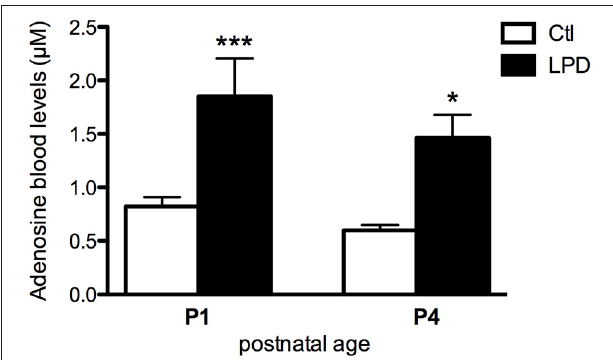
FIGURE 1 | Adenosine blood levels in animals exposed to antenatal low protein diet (LPD) and in control (Ctl) animals at postnatal day P1 and P4. Data are shown as the mean value ± S.E.M. (* p < 0.05, *** p < 0.001, using unpaired Student’s t